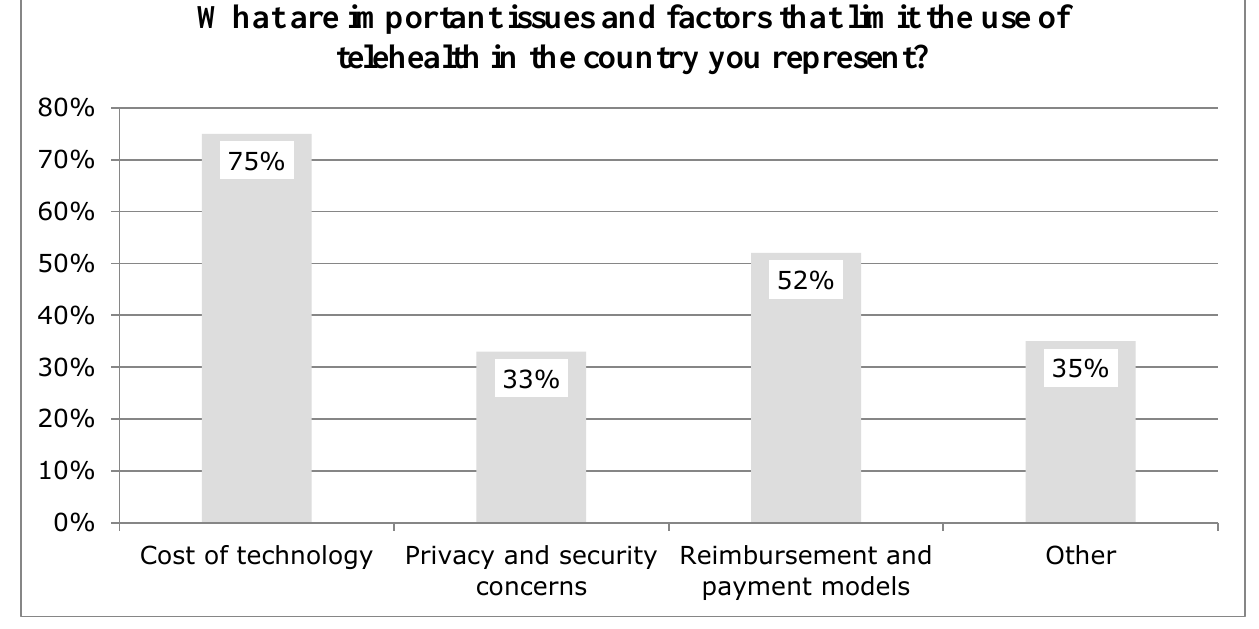
Table 2. Issues and Factors that Limit the Use of